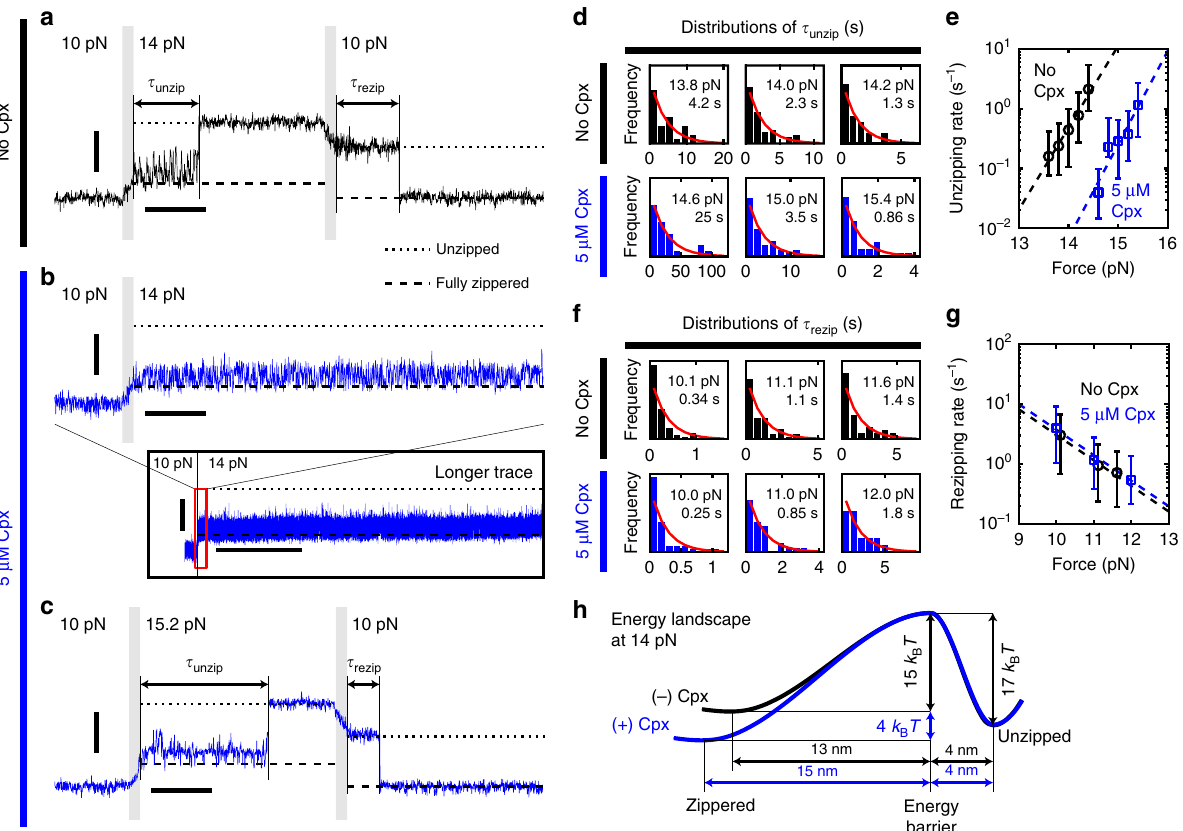
Fig. 2 Complexin extends the lifetime of zippered SNARE complexes under tension. a – c The force-jump scheme used for serial measurements of τ unzip and τ rezip in the absence ( a ) or presence ( b , c ) of Cpx. The predicted locations of the fully zippered and the unzipped states are indicated with dashed and dotted lines, respectively. Gray vertical bars mark the force-jump periods. Inset in b shows the marked increase in lifetime of SNARE induced by Cpx, the red box of which is magni fi ed above. Vertical scale bars represent 20 nm, and horizontal scale bars represent 0.5 s (main panels) and 30 s (inset in b ). d , f Distributions of τ unzip ( d ) and τ rezip ( f ) at varying forces ( N ≥ 19 for each panel). Red curves represent the fi ts to exponential distributions with their mean values indicated. e , g Force dependences of unzipping ( e ) and rezipping ( g ) rates in the absence (black) or presence (blue) of Cpx. Error bars represent the 95% con fi dence intervals for the mean parameter estimates in d and f . Dashed lines represent the fi ts to the Bell equation. h The energy diagram for the unzipping/zippering of a neuronal SNARE complex at 14 pN. The effect of Cpx is indicated in